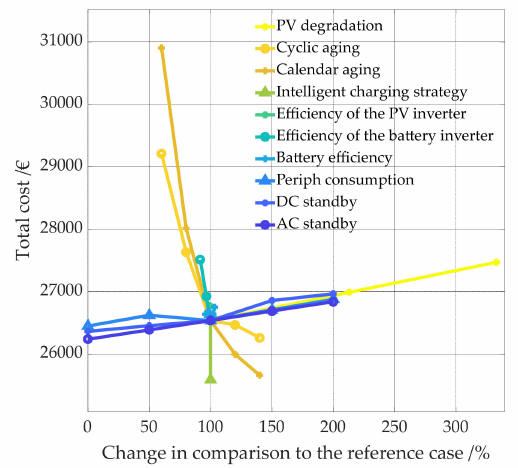
Figure 28. Change of energy costs depending on the change of different technical parameters. The selected PV system and battery combination is the combination that is the most favorable for the respective boundary conditions. The figure shows the total electricity costs over 20 years (calculation period) in €